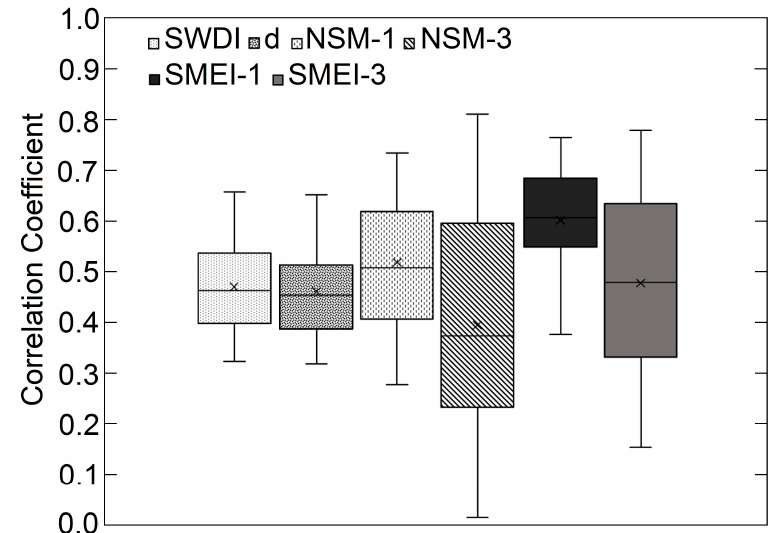
Figure 4. Box and whisker plots of correlation coefficients between SM and meteorological indices at all sites. Whiskers indicate the full range of estimated coefficients and crosses represent the mean.